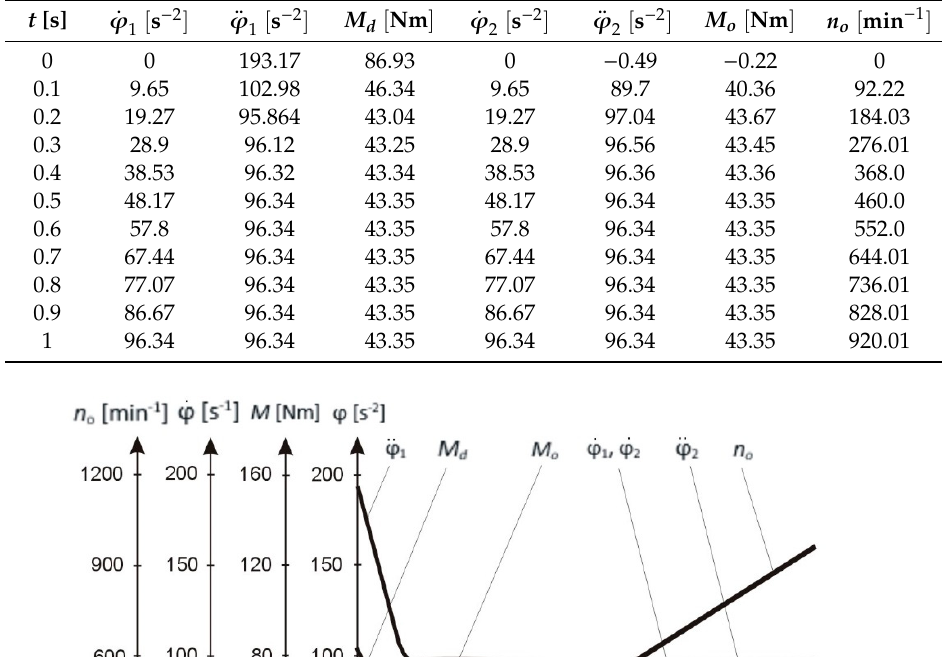
Table 4. Values of parameters of the technological process of shaft machining.